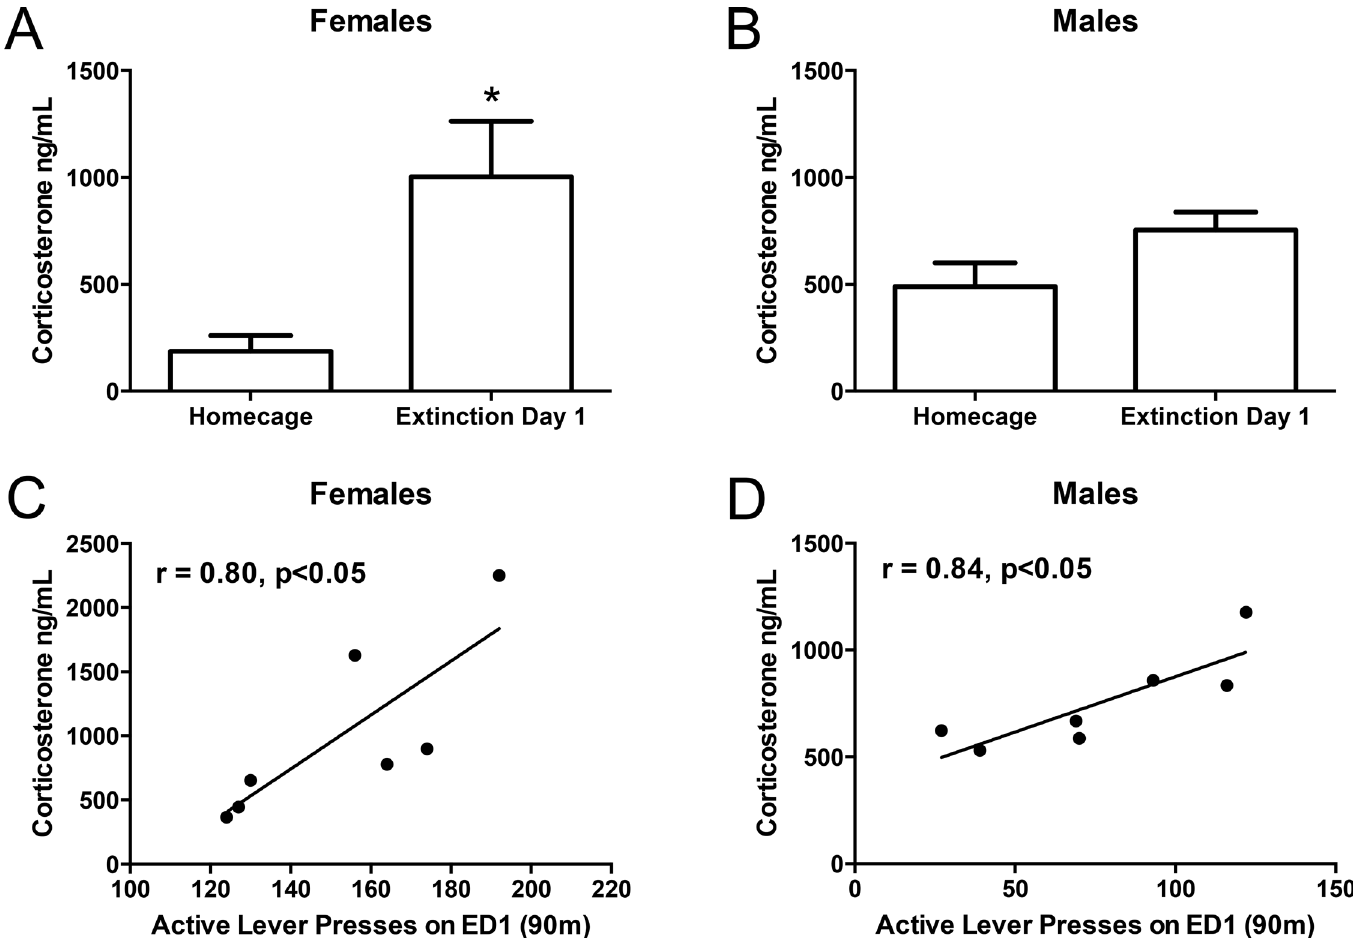
Fig 5. Effects of ED1 on Plasma Corticosterone Levels. Plasma corticosterone levels (ng/mL) were increased during initial abstinence (ED1) compared to homecage controls among female rats. * p < 0.05 versus homecage controls on ED1 (A). Plasma corticosterone levels significantly correlated to ED1 active lever pressing among female (C) and male (D)